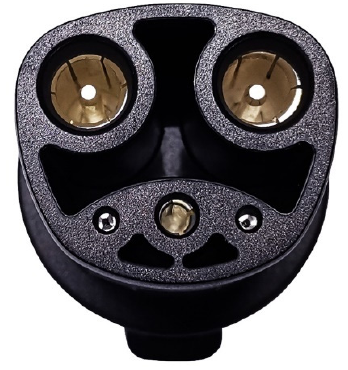
Figure 28. Tesla EV